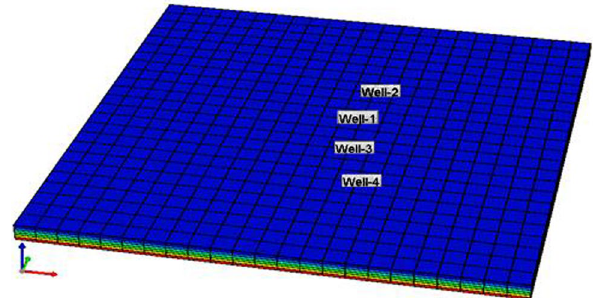
Fig. 5 Grid block with four production